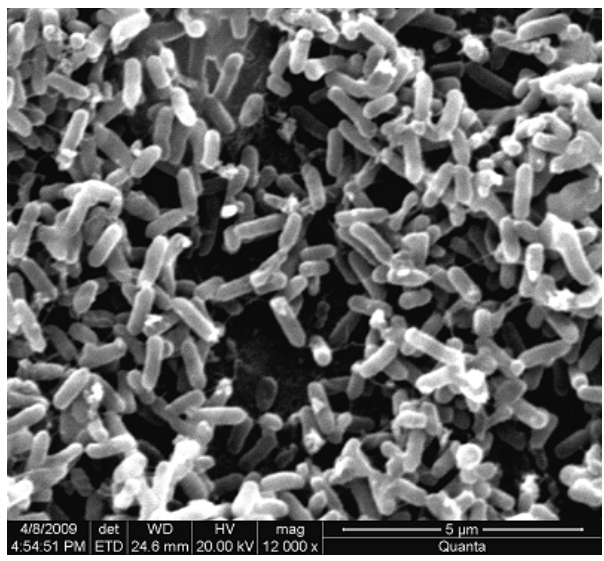
Figure 1. Scanning electron microscopy image of EMS